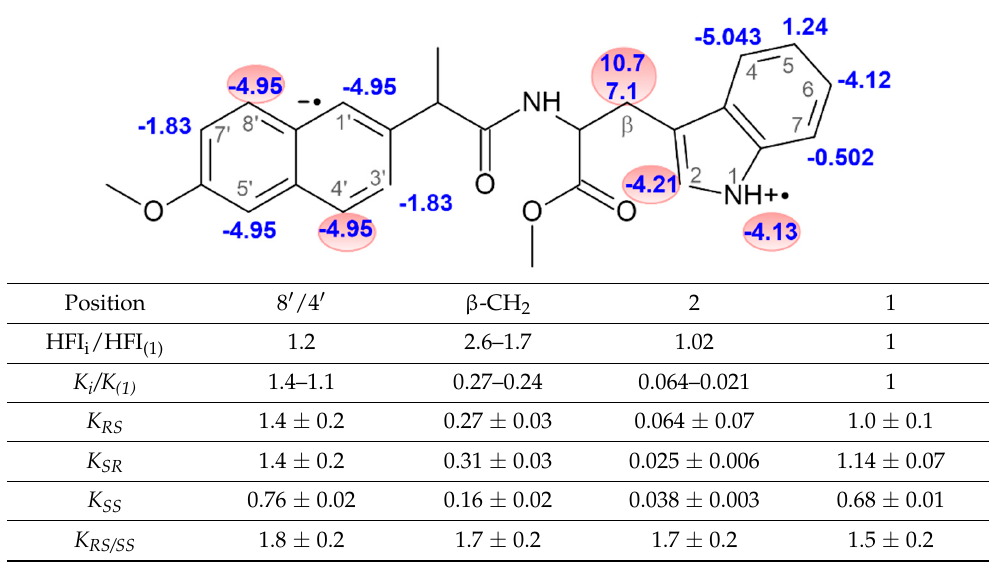
Table 2. The ratios of HFI constants and the observed CIDNP coefficients ( K ) relative to 1-NH and the values of the observed CIDNP coefficients for protons of dyad III in CD 3 CN solution.